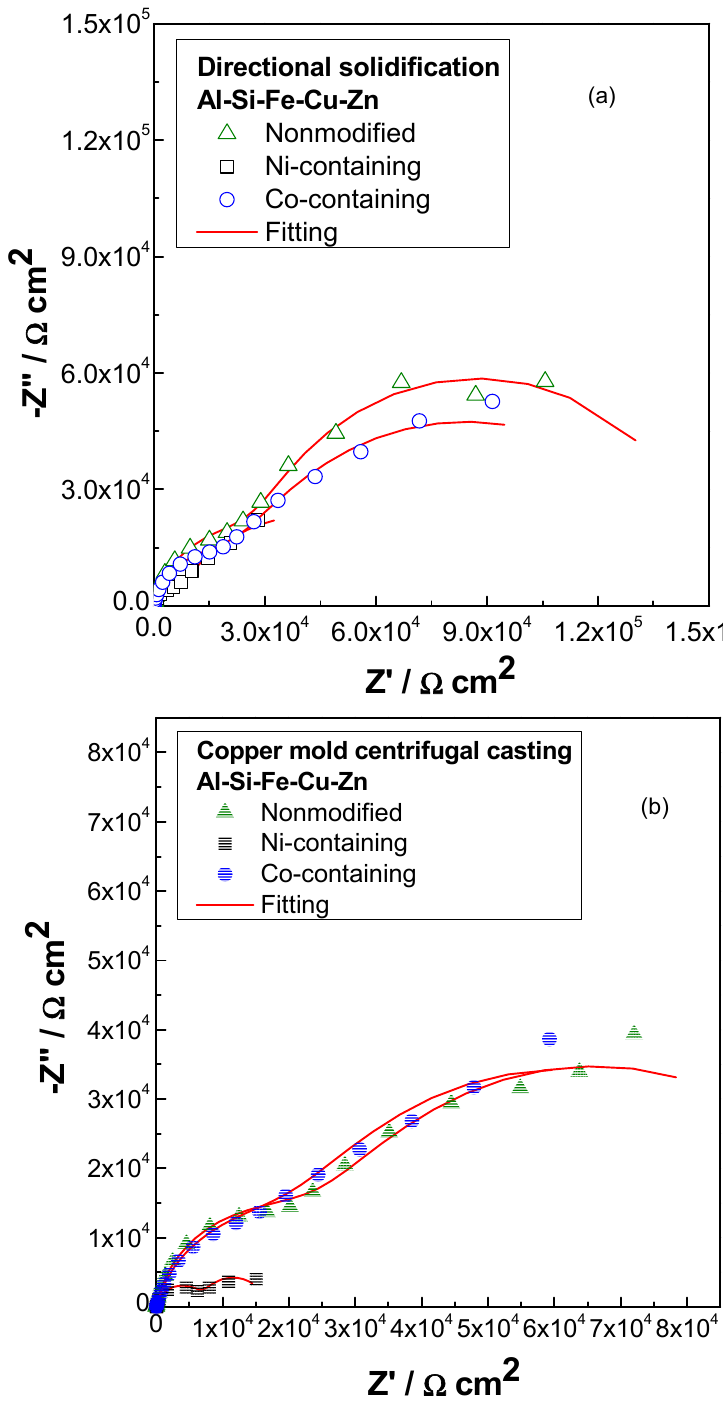
Figure 6. Nyquist plots related to the Al-Si-Fe-Cu-Zn (-Co, -Ni) alloy samples having different SDAS: Approximately ( a ) 21 μ m, ( b ) 5 μ m.